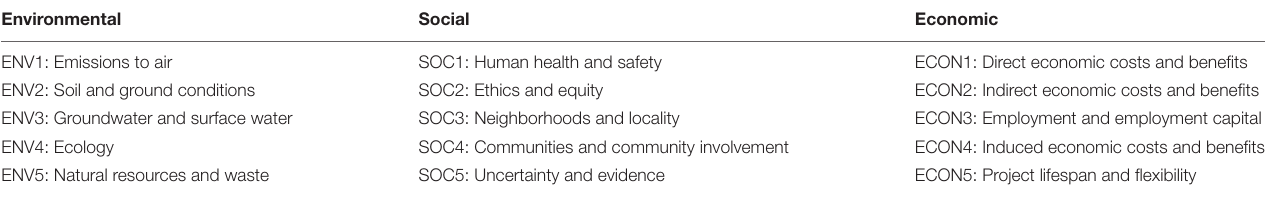
TABLE 2 | SuRF-UK headline categories for sustainability indicators (CL:AIRE, 2011, 2020). Environmental Social